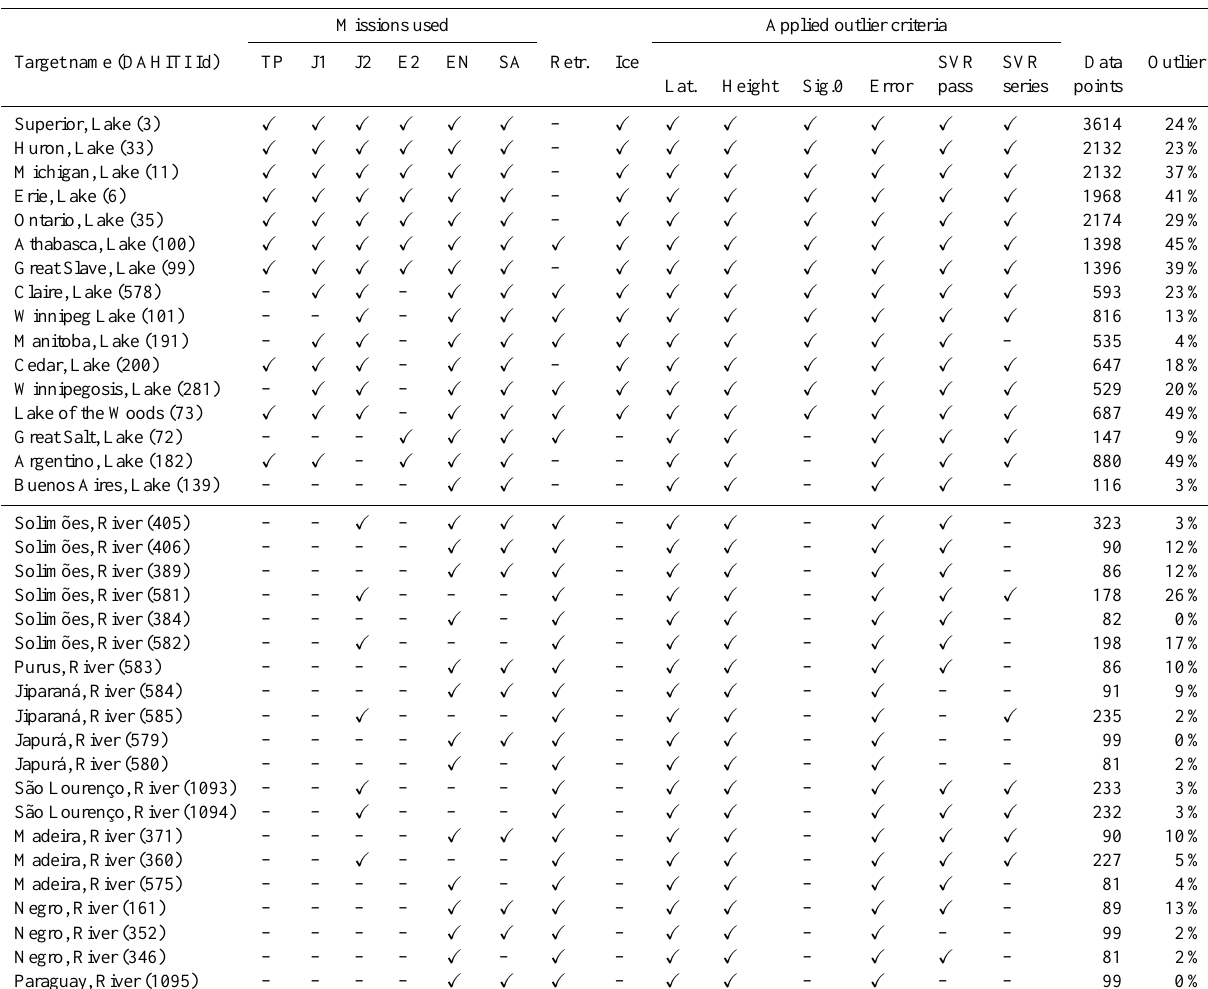
Table 3. Relevant parameters for the estimation of the water level time series for DAHITI. This table shows information about the altimeter missions used for selected lakes and rivers, applied retracking (Retr.), ice coverage (Ice), and applied outlier criteria which are used for the processing of water level time series. Finally, the number of data points and percentage of outliers of the final water level time series are